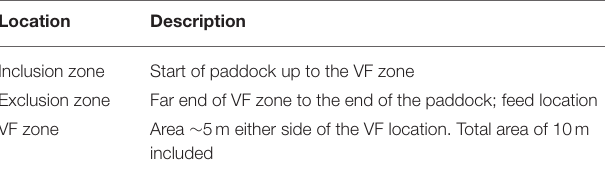
TABLE 3 | The location description used during the behavioural